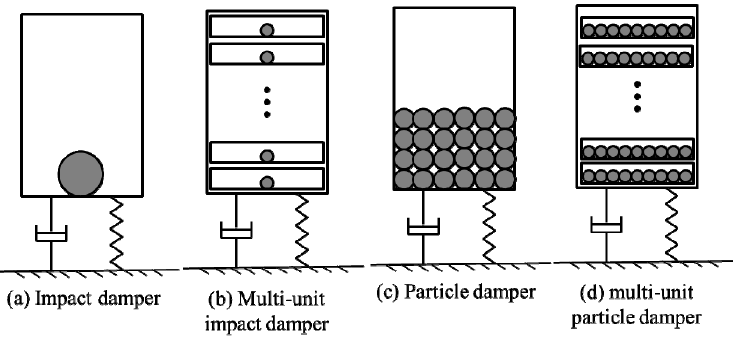
Figure 1. Classification of particle dampers.